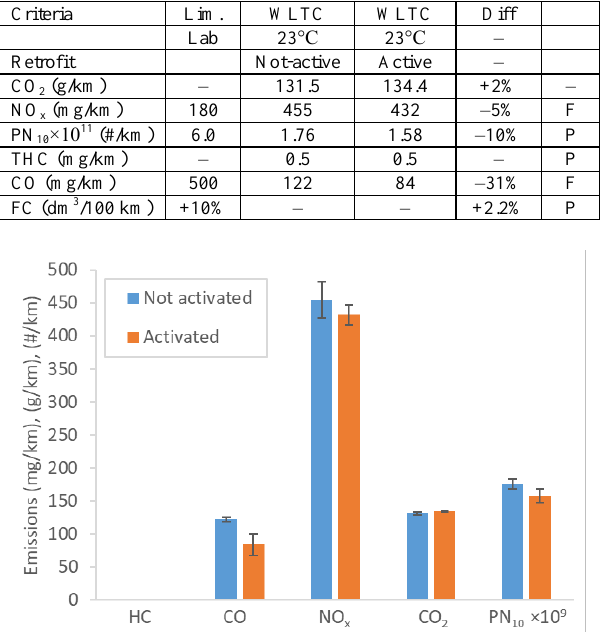
Table 5. Emissions measured by JRC for the cycles prescribed in the prize rules. F = Fail, P = Pass based on the Engine limits because the prototype vehicle was delivered for the Engine prize (Table 1). Lim. = Limits Criteria